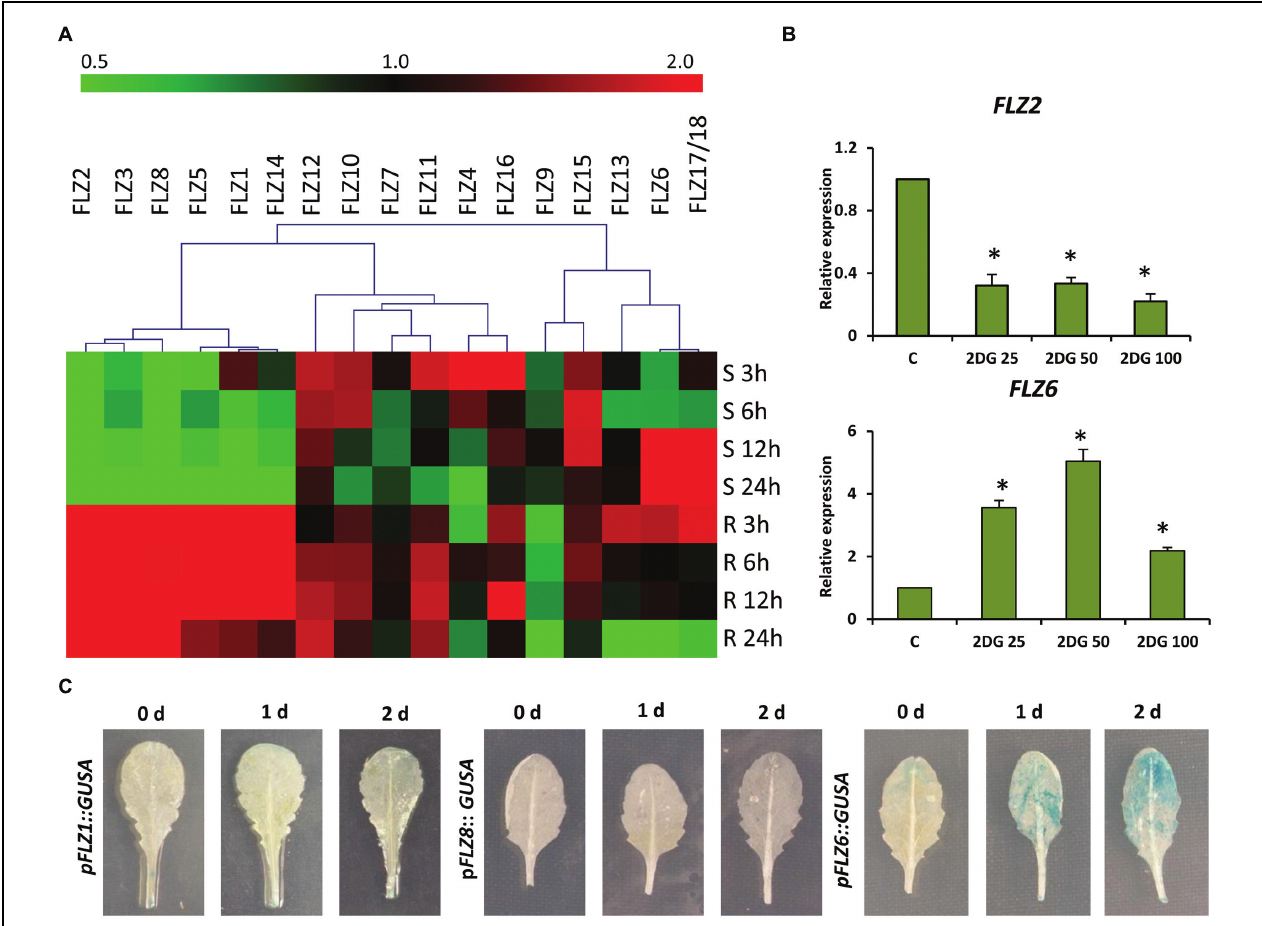
FIGURE 1 | Expression of Arabidopsis thaliana FLZ gene family during low-energy stress and replenishment. (A) Expression of A. thaliana FLZ gene family under energy starvation and replenishment studied with qRT-PCR. S denotes ‘starvation’ and R denotes ‘recovery.’ The expression in 0.5X MS grown plants was taken as the control to compare the expression in low-energy levels and replenishment series. The genes were subjected to hierarchical clustering based on their response toward these treatments. UBQ10 was used as endogenous control. (B) Expression of FLZ2 and FLZ6 in response to increasing concentration of 2DG (25, 50, and 100 mM). The bars represent the average of two independent biological experiments with three technical replicates each and error bars represent SE. UBQ10 was used as endogenous control. Asterisk indicates a significant difference of expression in the treatment compared to control ( P < 0.005, Student’s t -test). (C) The response of pFLZ1 :: GUSA , pFLZ8 :: GUSA , and pFLZ6 :: GUSA transcriptional-reporter lines toward energy starvation for 0, 1, and 2